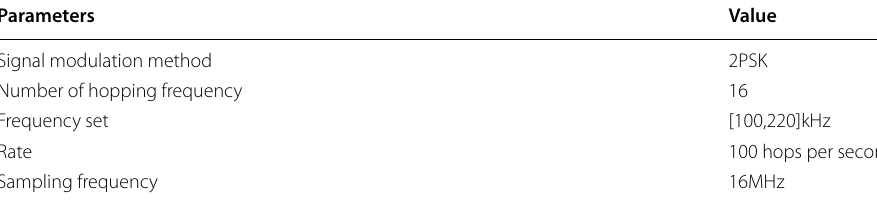
Table 2 Parameters of frequency hopping signal Parameters